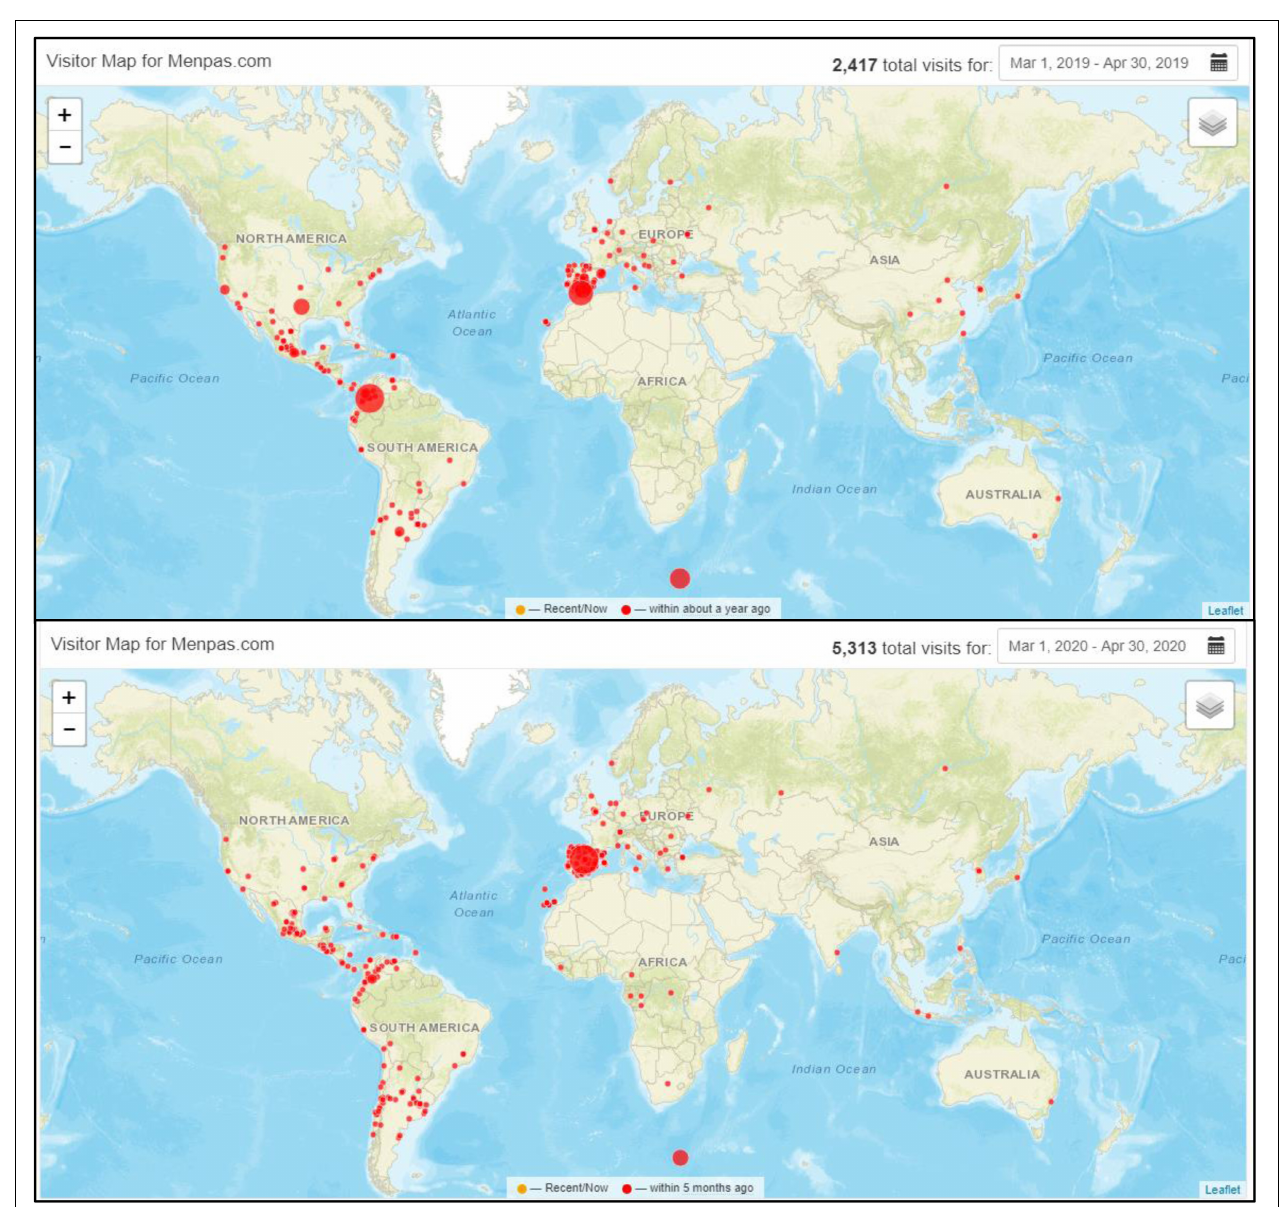
FIGURE 2 | MenPas users (March and April ’19 vs. March and April ’20) by